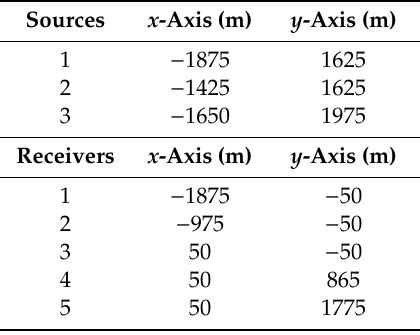
Table 2. Sources and receivers’ coordinates for the Cape Busto location.